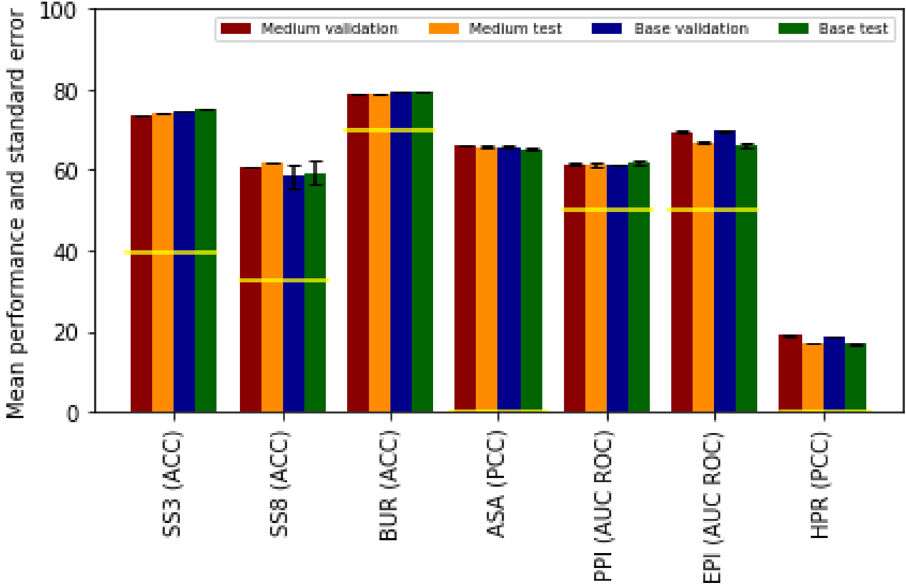
Figure 3. Performance on downstream task is generally stable between test and validation sets. Prediction performances of the benchmark validation and test set for both the converged medium and base models. Further details are given in Fig.